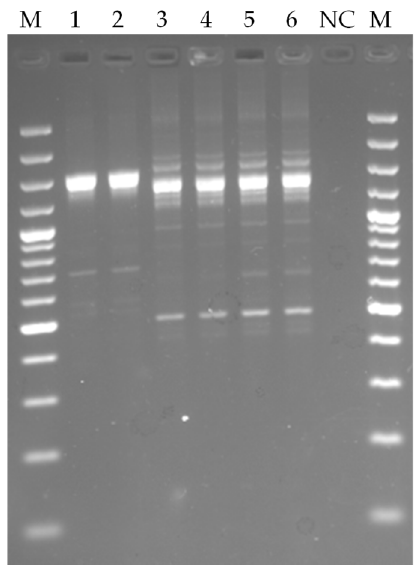
Figure 1. Image of agarose gel showing randomly amplified polymorphic DNA profiles of commer- cial starter lactic acid bacteria (LAB). Lanes M, GeneRuler 100 bp plus DNA ladder (Thermo Fisher Scientific, Inc., Vilnius, Lithuania); lanes 1-2, strain 1; lanes 3-6, strain 2; lane NC, negative control.